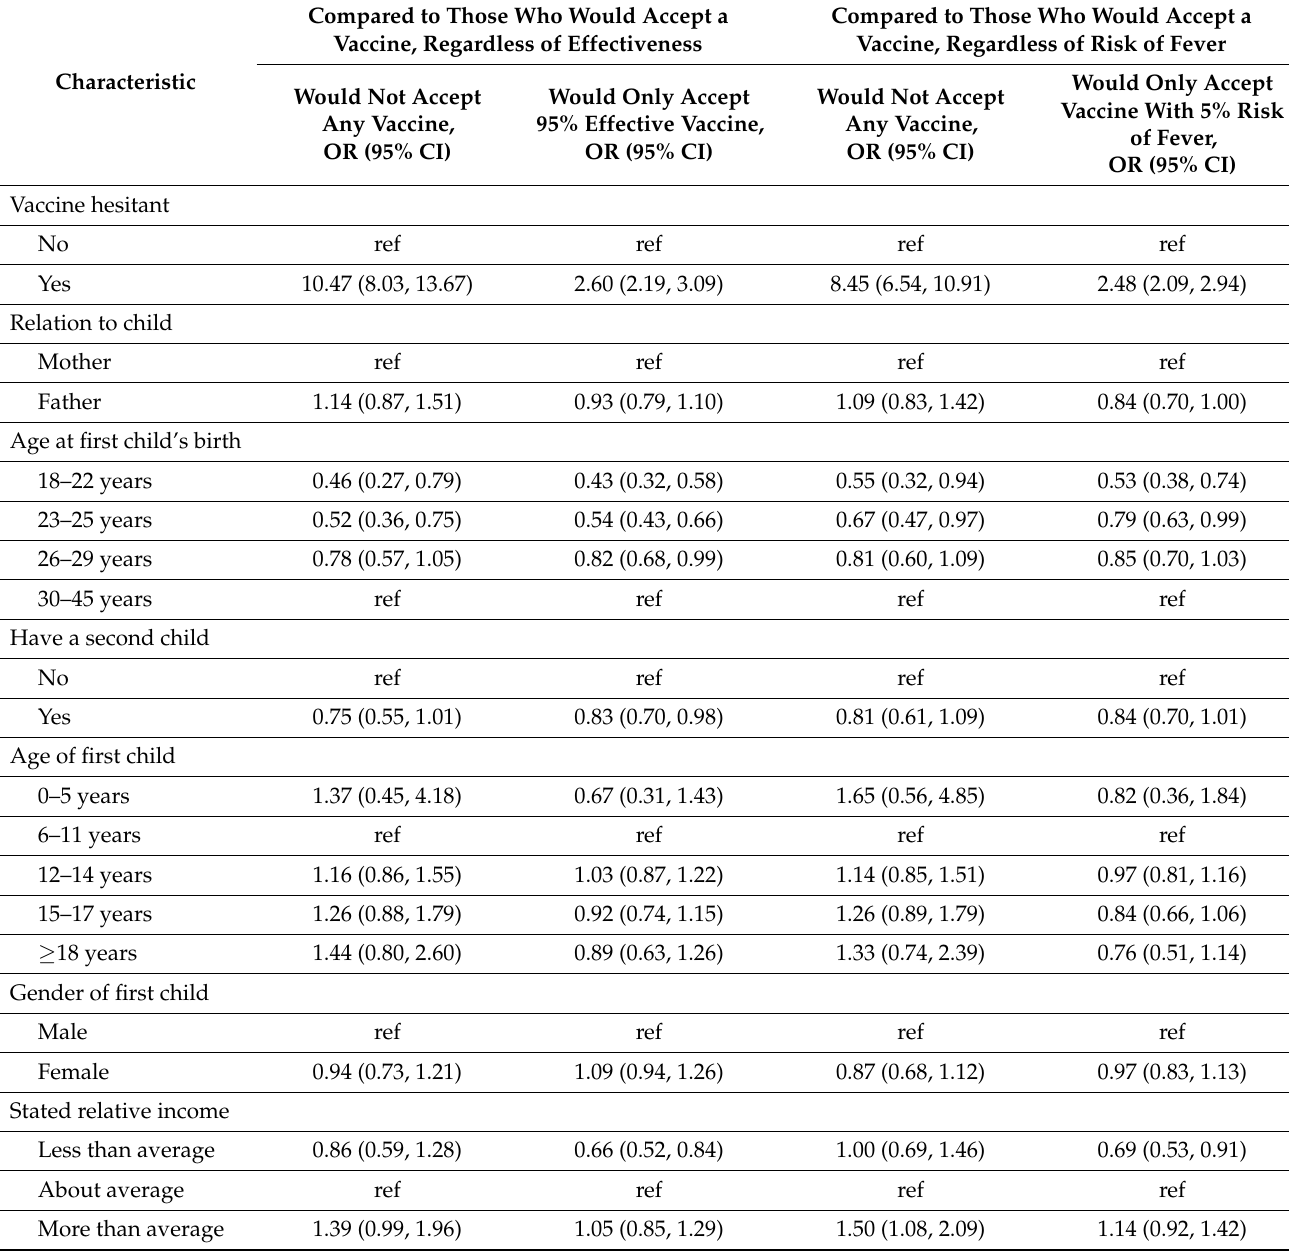
Table 3. Sensitivity to COVID-19 vaccine effectiveness and safety in multinomial logistic regression models among Shanghai parents of school-aged children,